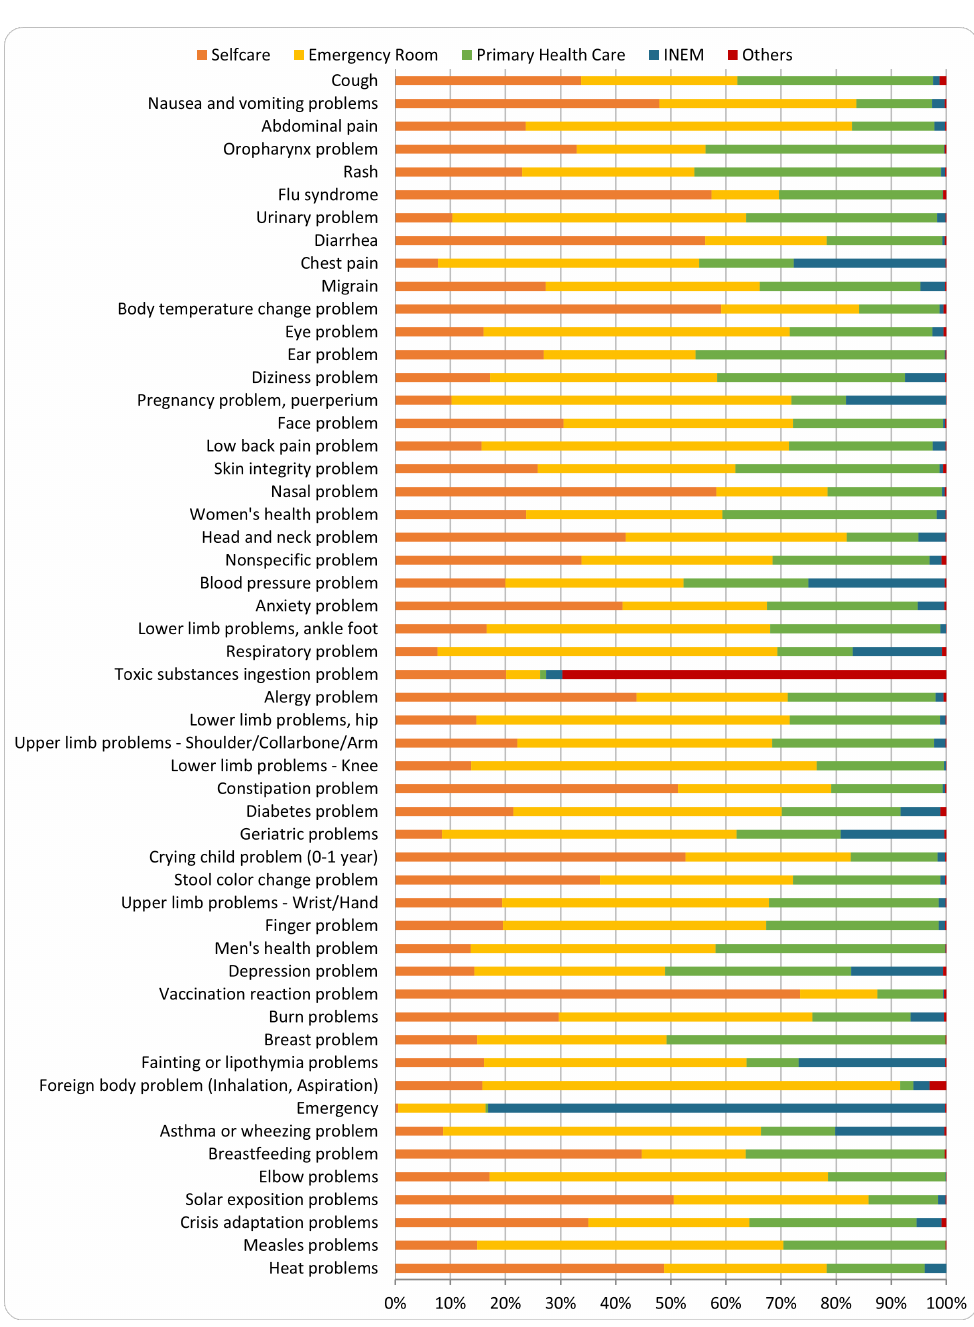
Figure 8. Distribution of referrals per pathway. Figure 9 further presents the same analysis but for the 10 most common pathways, ar- ranging them by the percentage of selfcare referral: “Body temperature change”, “Diarrhea” and “Flu syndrome” have percentages higher than 50%; “Cough”, “Oropharynx problems” and “Nausea and vomiting problems” have percentages higher than 30% and lower than 50%; “Abdominal pain” and “Rash” have a similar selfcare of around 23%; “Chest pain” and “Urinary problems” have selfcare percentages lower than 10%. On the other end, around 28% of “Chest pain” are referred to INEM and around 60% of “Abdominal pain” and 50% of “Urinary problems” and “Chest pain” calls are referred to the emergency